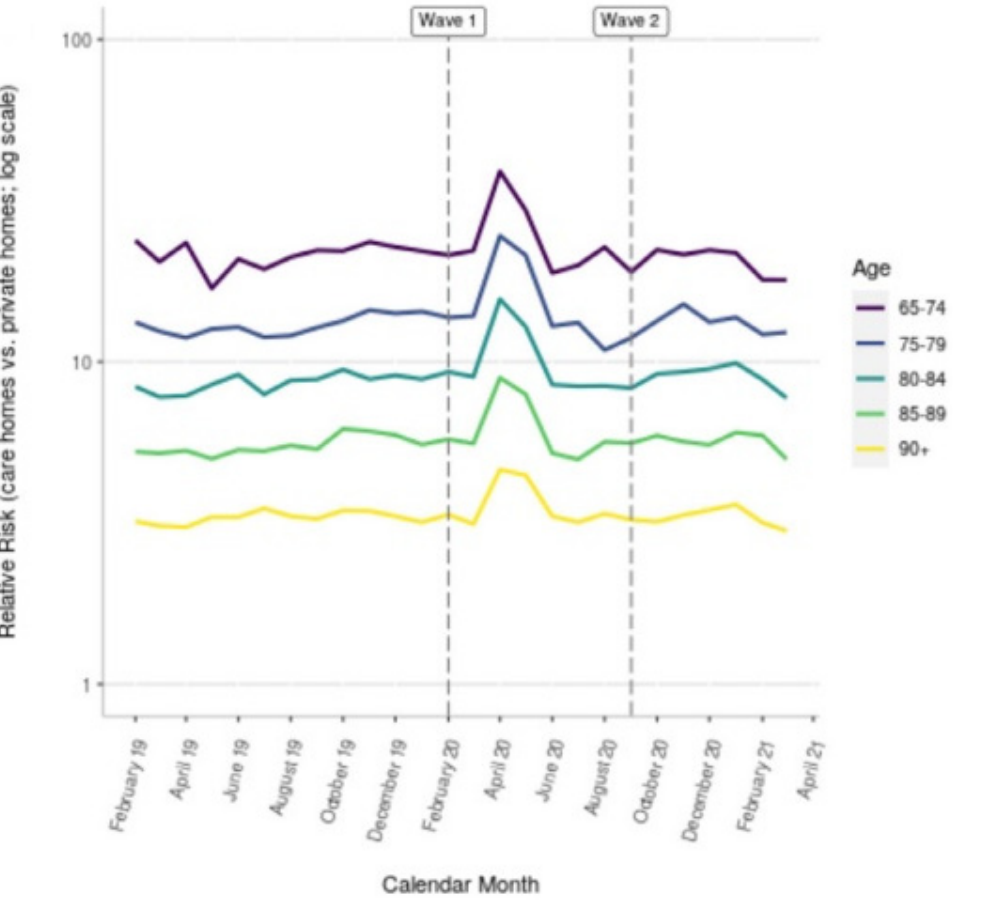
Figure 15. Relative death risks in care homes of